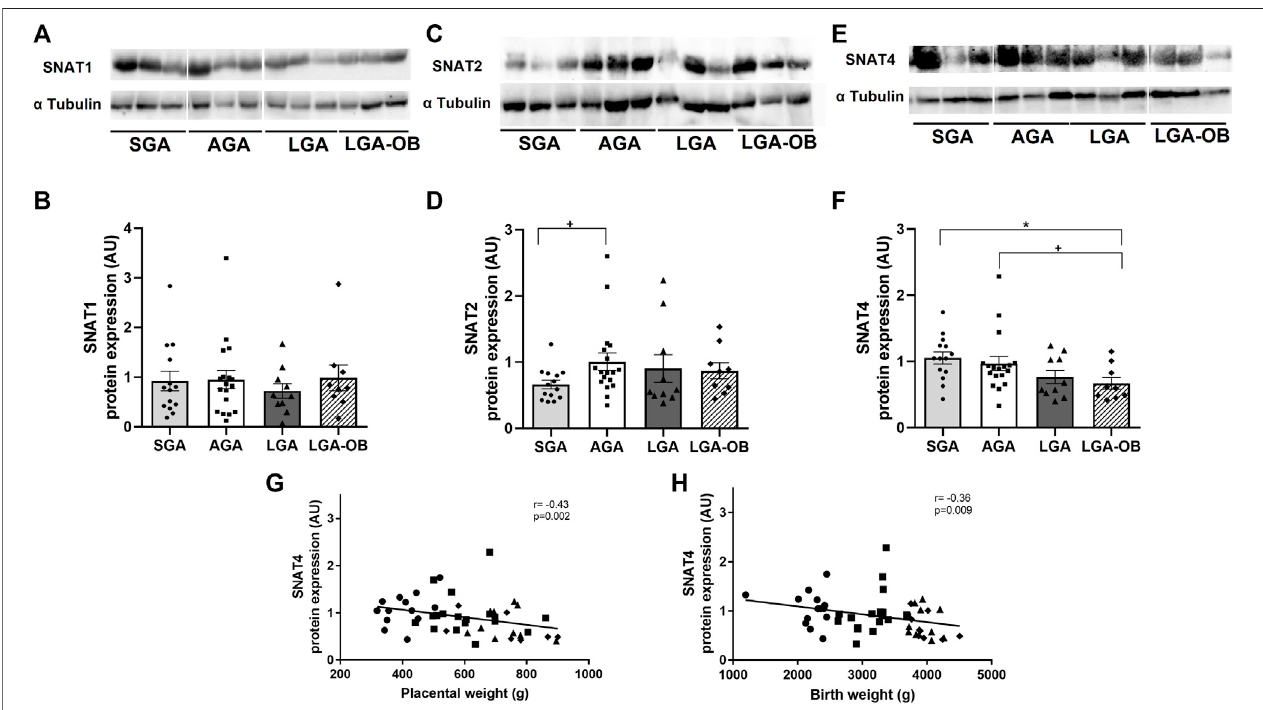
FIGURE 2 | Protein expression of amino acid transporters in placentas of SGA, AGA, LGA, and LGA-OB newborns. Representative Western blot of SNAT1 (A), SNAT2 (C), and SNAT4 (E) in placentas of SGA (n = 14), AGA (n = 18), LGA (n = 10), and LGA-OB (n = 9) newborns. Bands presented correspond to the same membrane.Quanti fi cation ofSNAT1 (B), SNAT2 (D), and SNAT4 (F) protein expressions intheplacentabyimmunodetection. Dataaremean±SE.*denotessigni fi cant difference ( p < 0.05) between groups by ANOVA. + denotes signi fi cant difference when compared to control AGA by Student´s t test. Correlation between the placental expression of SNAT4 with placental weight (G) and birth weight (H)